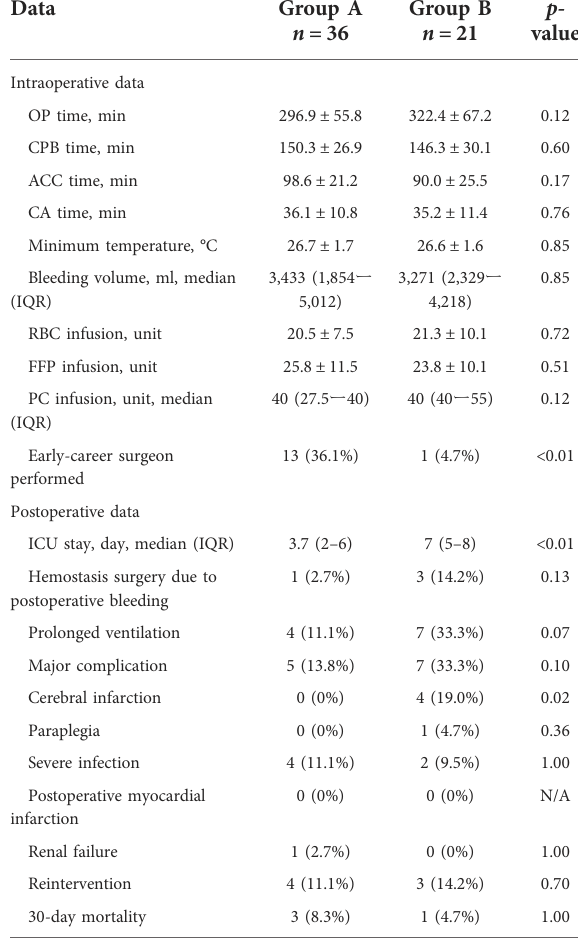
TABLE 2 Intraoperative and postoperative